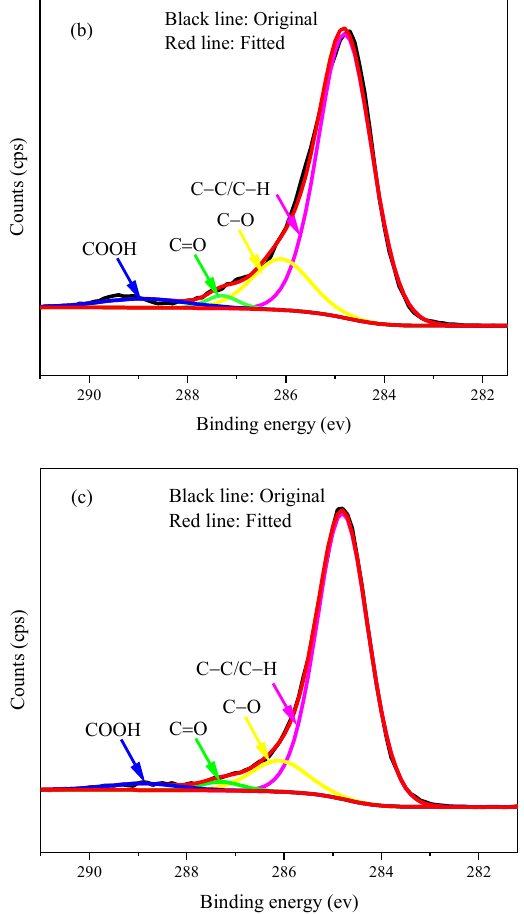
Figure 8. Deconvolution of C1s XPS spectra of three coal chars: ( a ) A600; ( b ) B600; ( c ) C600. Table 3. Normalized relative content (%) of carbon functionalities of C1s XPS spectra.